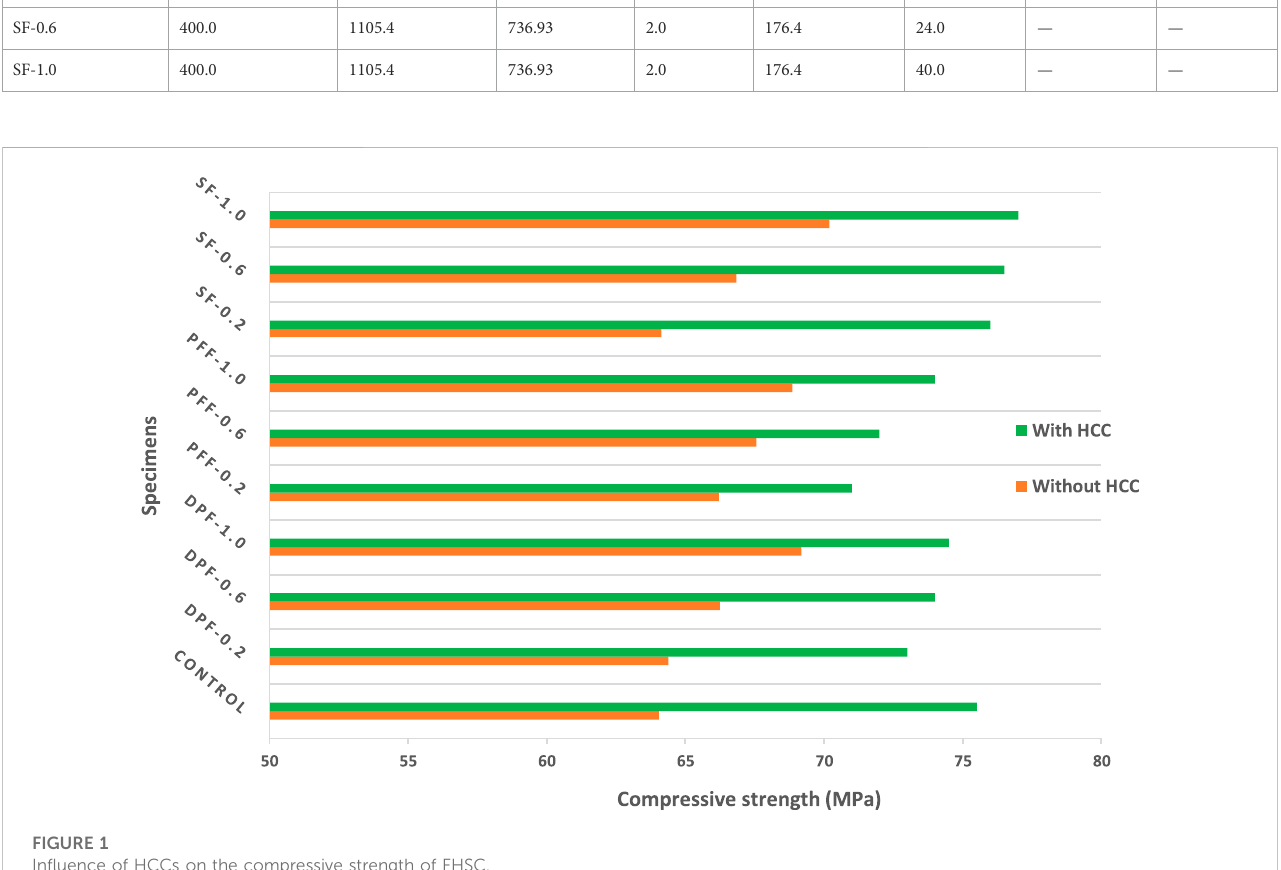
FIGURE 1 In fl uence of HCCs on the compressive strength of